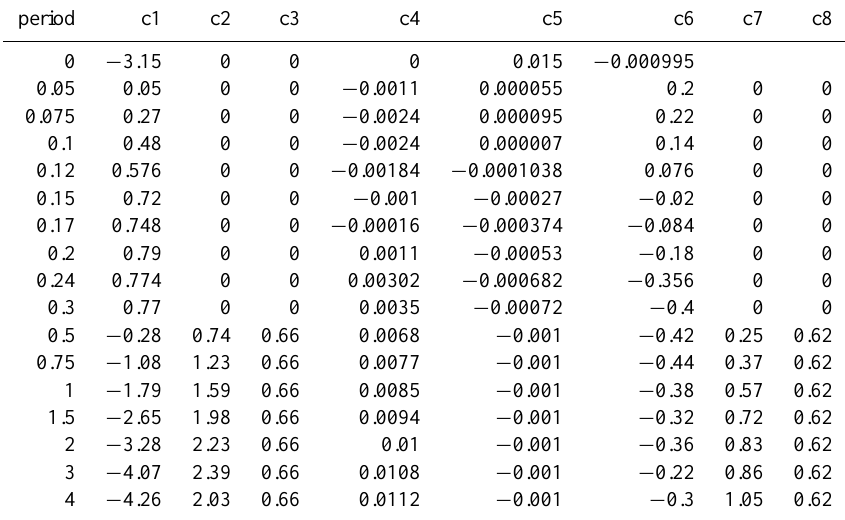
Table 4. Coefficients of the horizontal response spectral accelerations (5% damping) for rock sites.